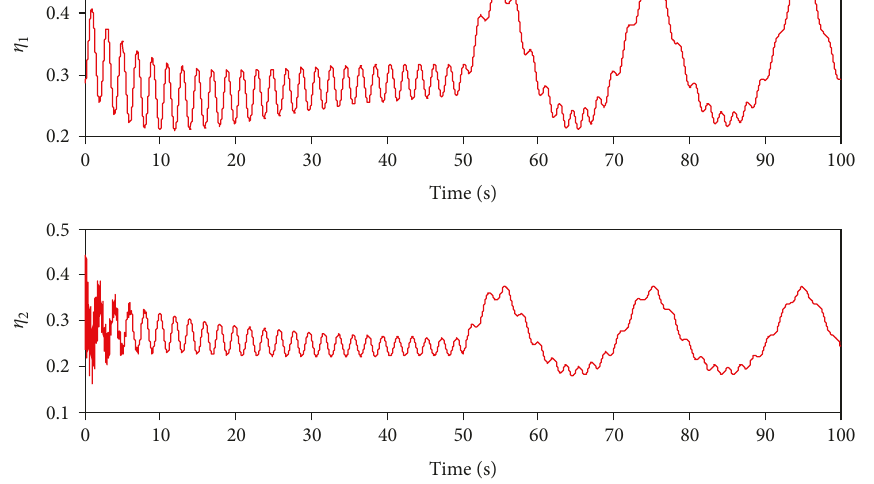
Figure 13: Variation curves of fl exible states.